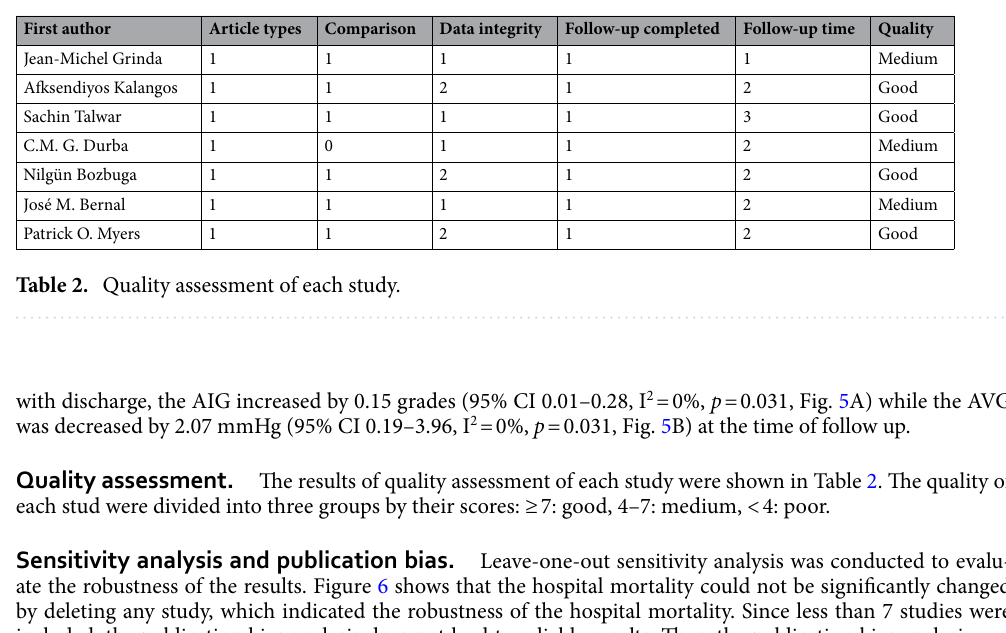
Figure 5. Forest plot of WMD of AIG ( A ) and AVG ( B ) between discharge and follow up. WMD weighted mean differences, CI confidence interval.